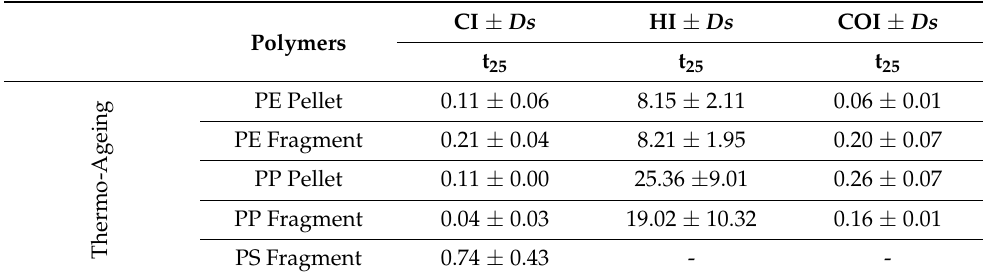
Table 4. Comparison of CI, HI, and COI calculated for each polymer. Values are expressed as an average of two replicates ± standard deviation ( Ds ) after 25 days of incubation at 45 ◦ C in a dry condition.